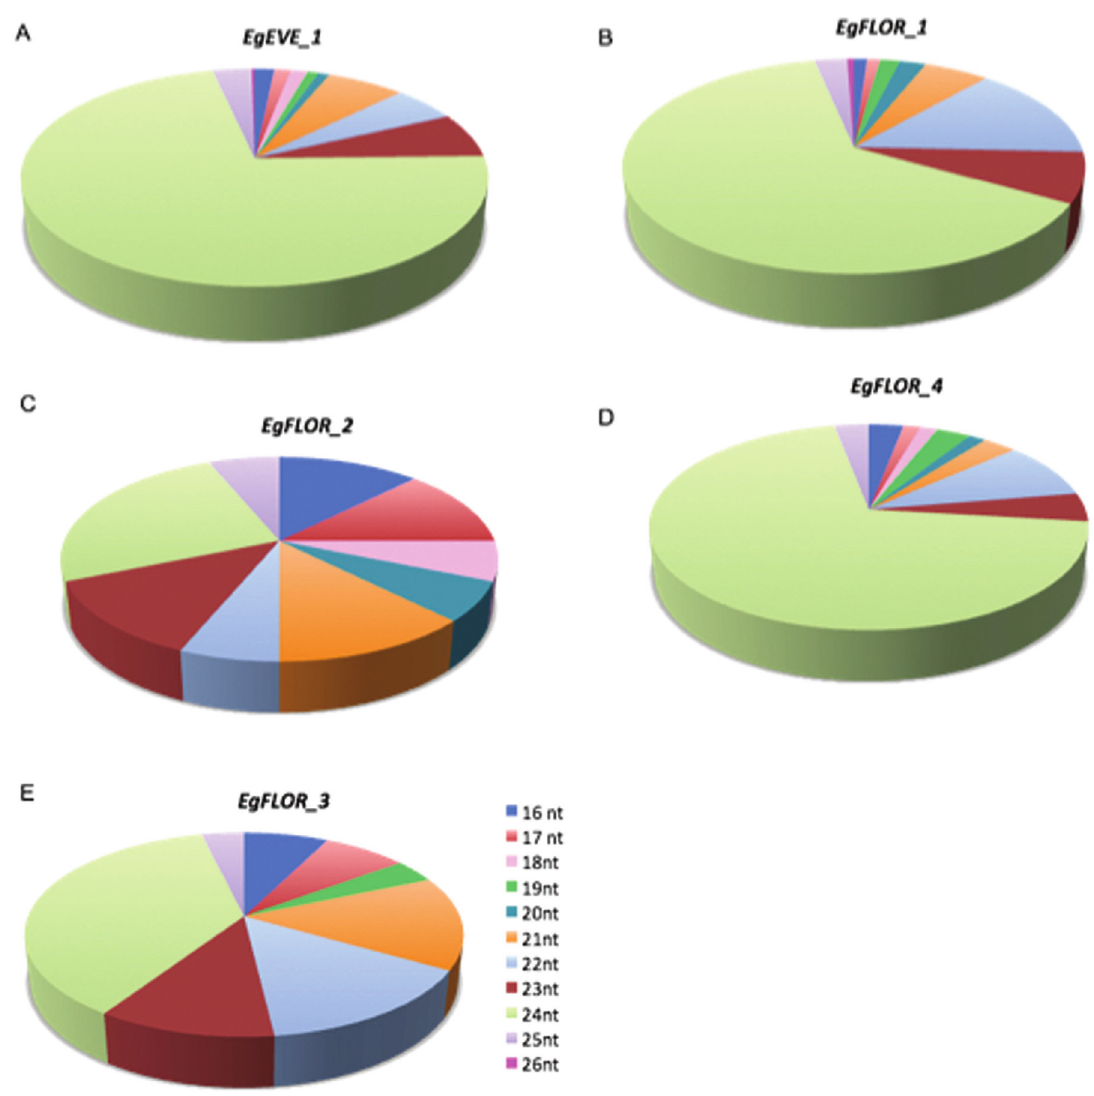
Figure 4 - Size variation of sRNAs (16 to 26 nucleotiotides) according to EVE. (A) EgEVE_1 , (B) EgFLOR_1 , (C) EgFLOR_2 , (D) EgFLOR_3, (E)